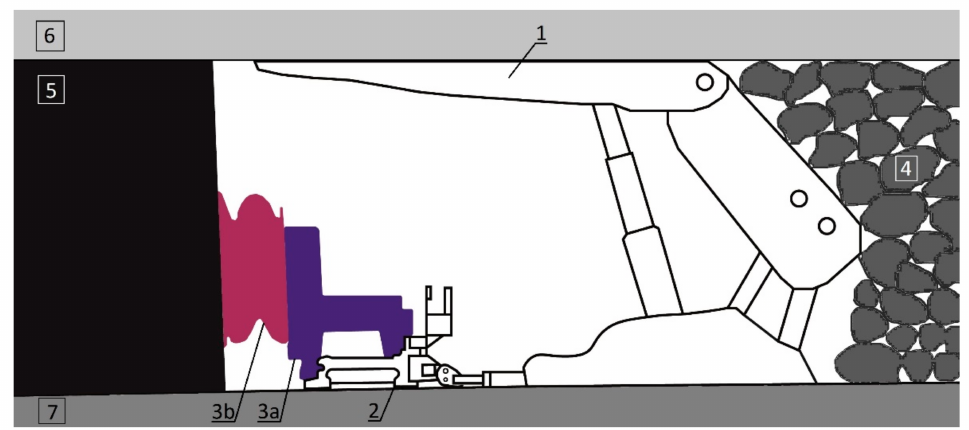
Figure 1. Mechanized wall complex, where 1—powered roof support, 2—longwall scraper conveyor, 3a—shearer, 3b—cutting unit, 4—goafs, 5—coal, 6—roof, and 7—floor.